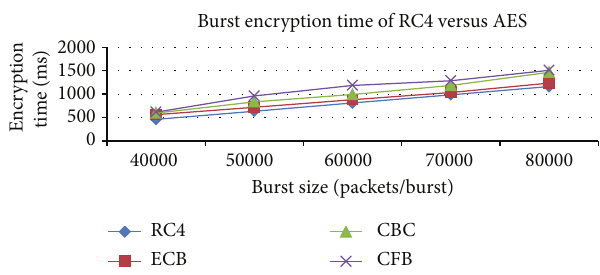
Figure 3: Comparison of burst encryption time with various algorithms.